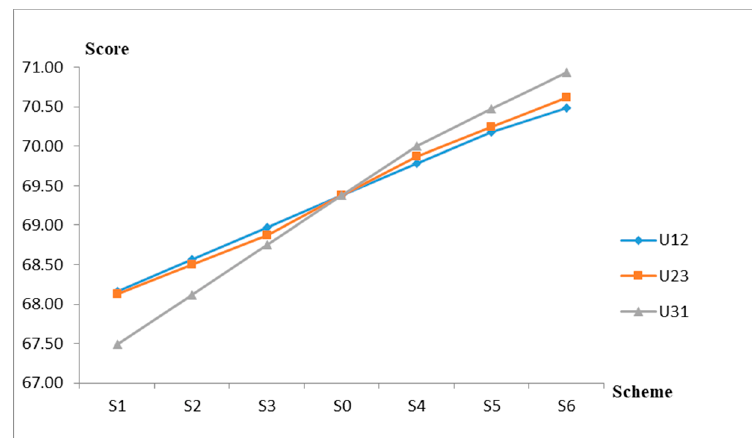
Figure 3. Sensitivity diagram of selected secondary indicators.